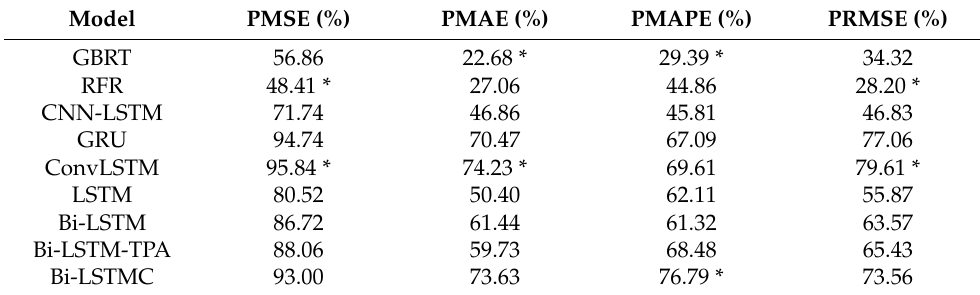
Table 3. Promotion percentage of Bi-ConvLSTM-CA compared with other